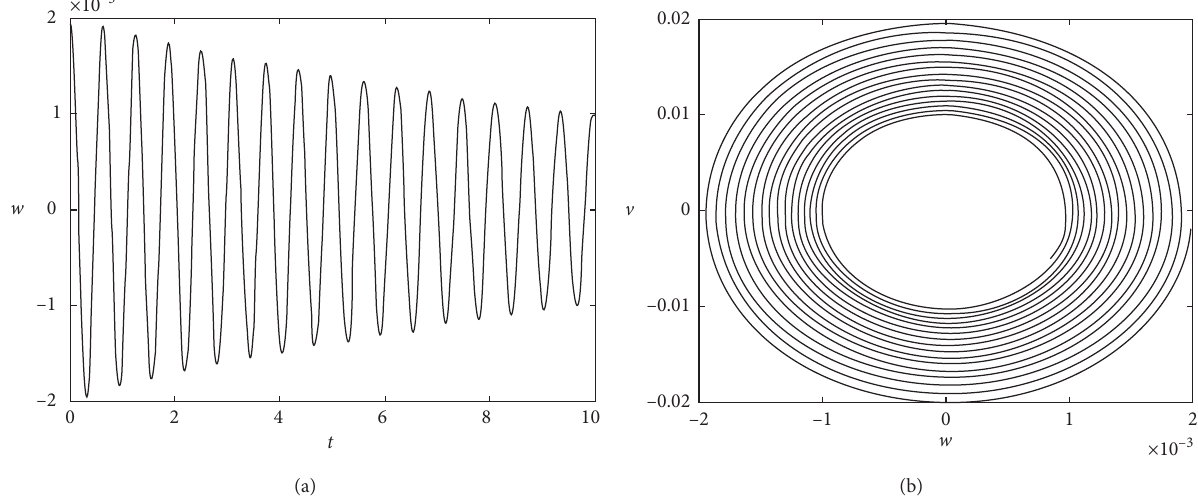
Figure 16: Stable state of the system when the inflow velocity U ) and (b) phase portrait on plane ( w , v ) plane ( t, x 1